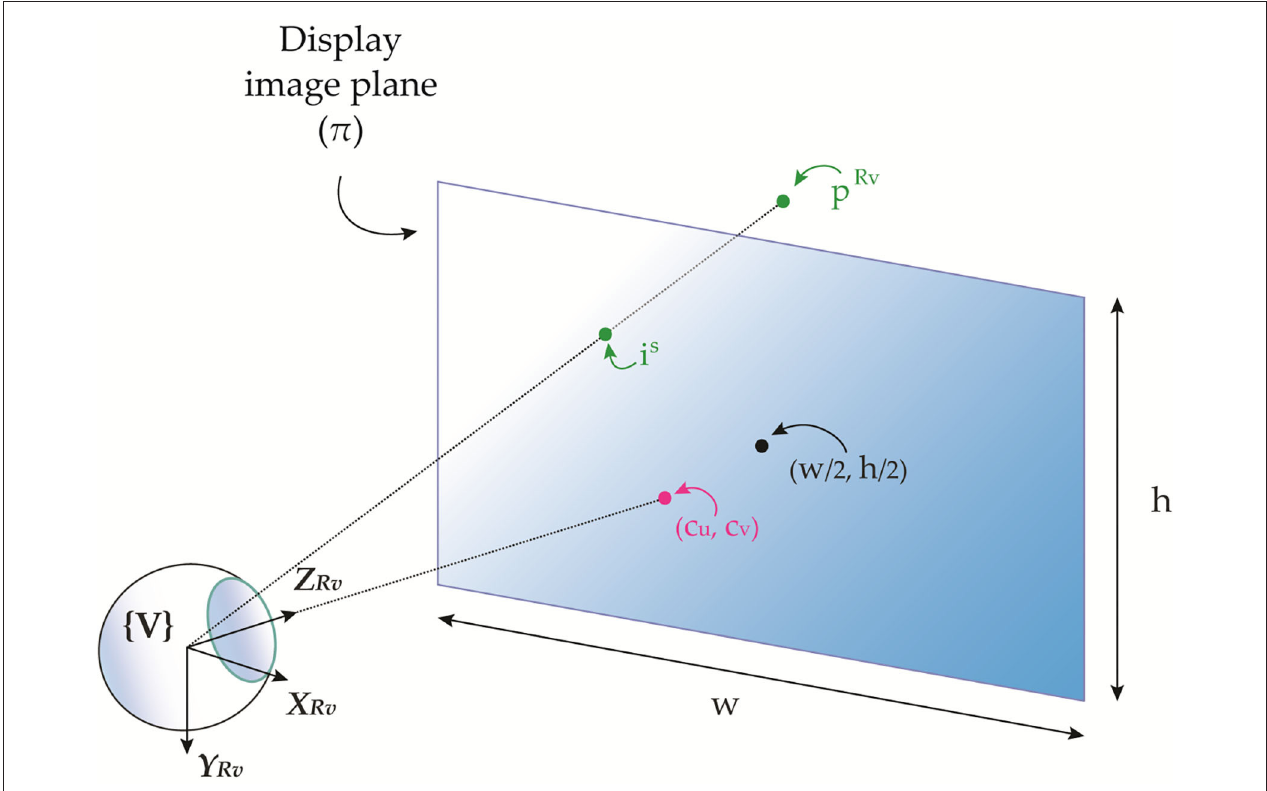
FIGURE 1 | 3D representation of the combined eye-display off-axis pinhole model comprising the eye as the projection center and the see-through virtual screen as the image plane.